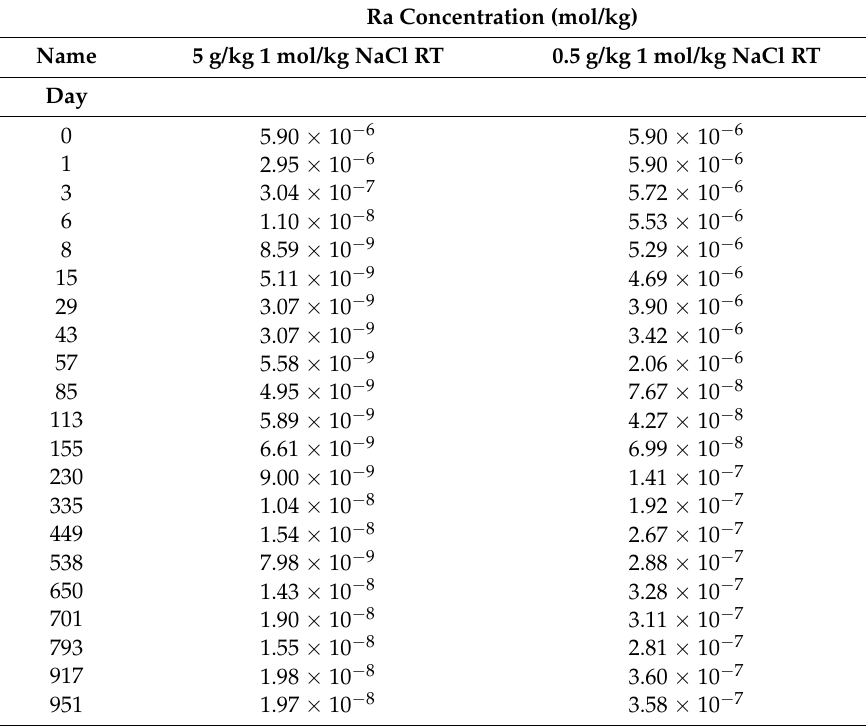
Table A1. Ra concentrations of experiments with 1.0 mol/kg NaCl at room